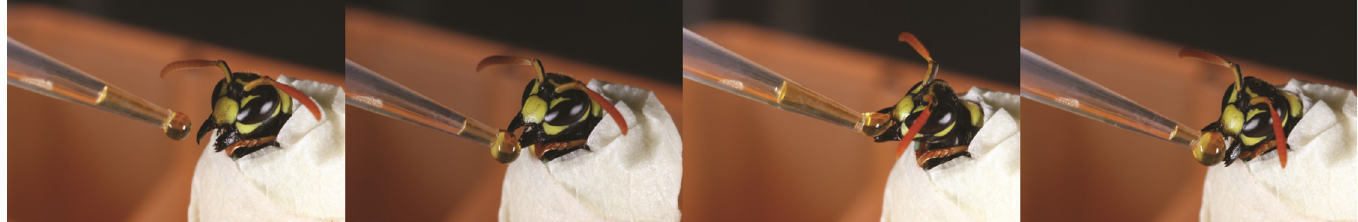
Fig 2. Feeding an immobilised P . dominula forager with a dsRNA solution to ensure that the wasps consumed the dsRNA solution provided in the cages, previous to the trials.